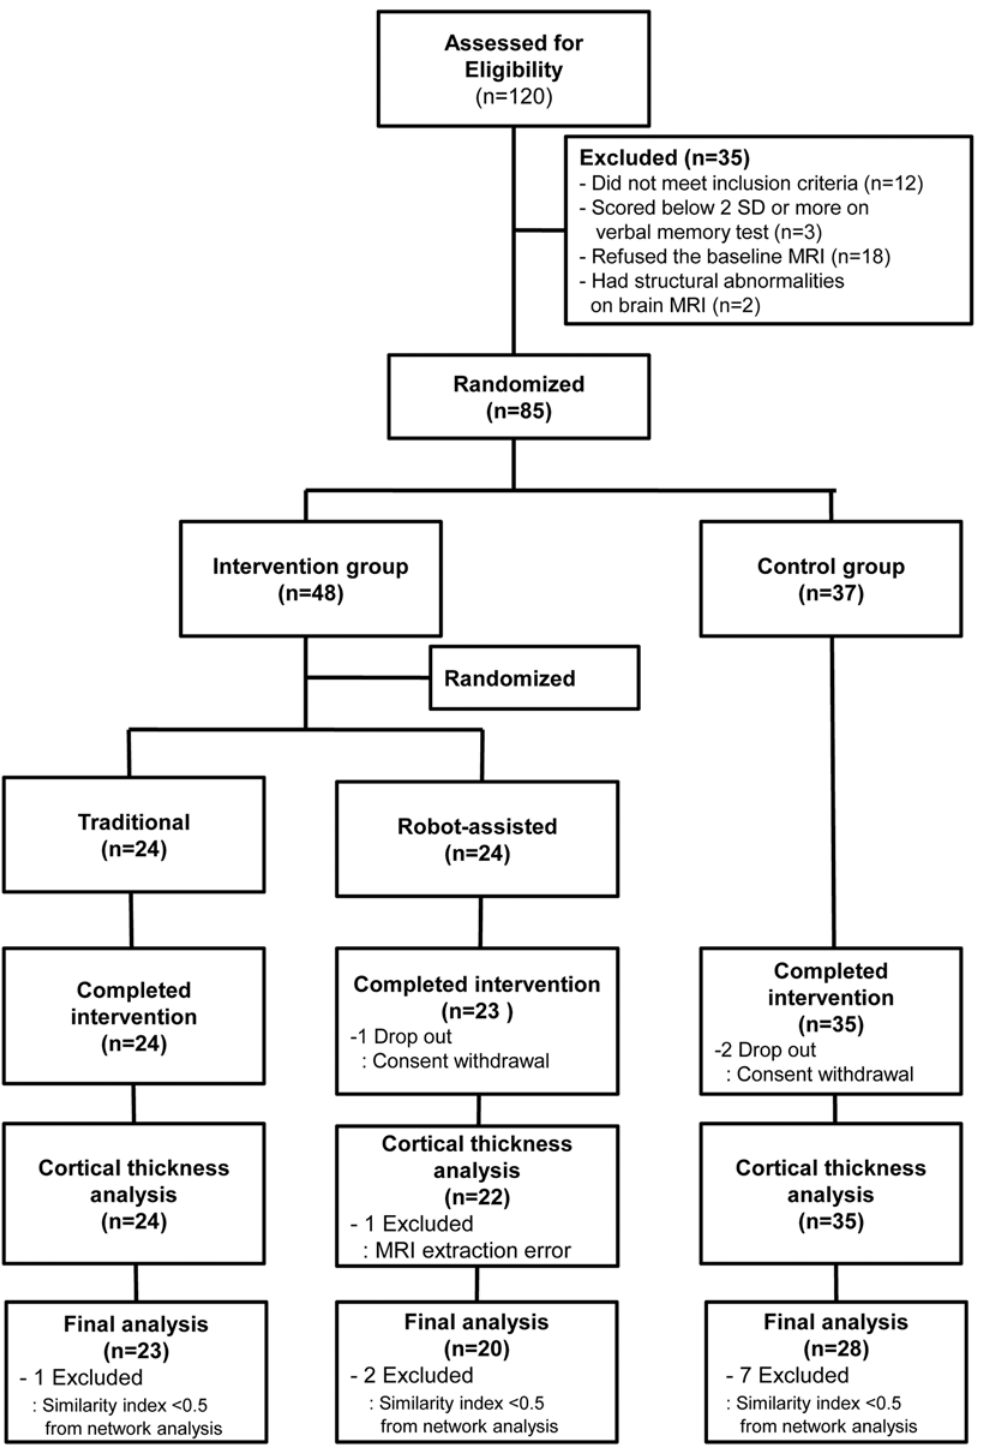
Fig 1. Flow of participants in this study. The similarity index was defined as follows:similarity index = 2 * nnz(A and B)/(nnz(A) + nnz(B)) where A and B are the baseline and post-intervention connectivity from binary matrices, respectively and nnz refers to the number of non-zero elements in a matrix. If the two binary matrices were the same, the similarity index was assigned a value of 1. We excluded subjects with a similarity index lower than 0.5 in our statistical analyses to reduce the artifactual effects related to the different times of scanning.